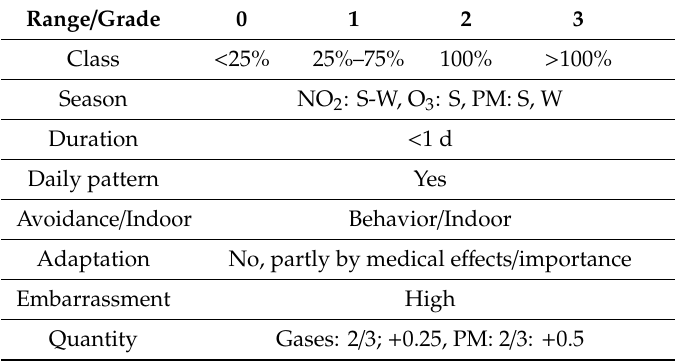
Table 5. Factors a ff ecting air